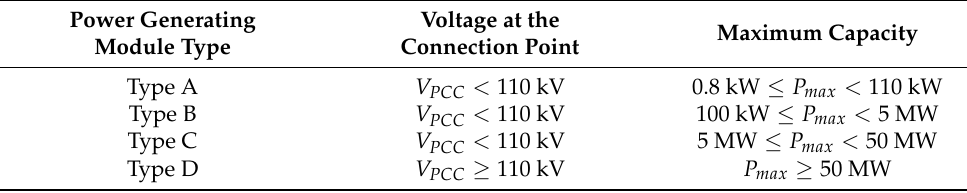
Table 1. Power generating module types according to the Spanish grid code [38].